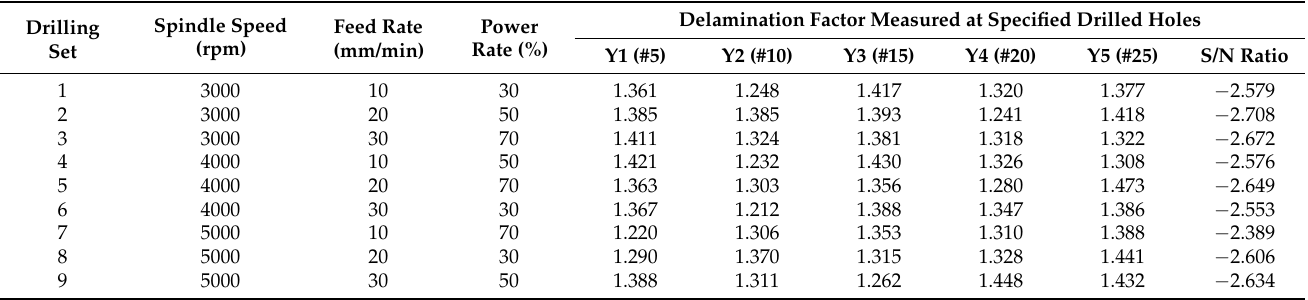
Table 4. Delamination factors measured for specific drilled holes for nine drilling